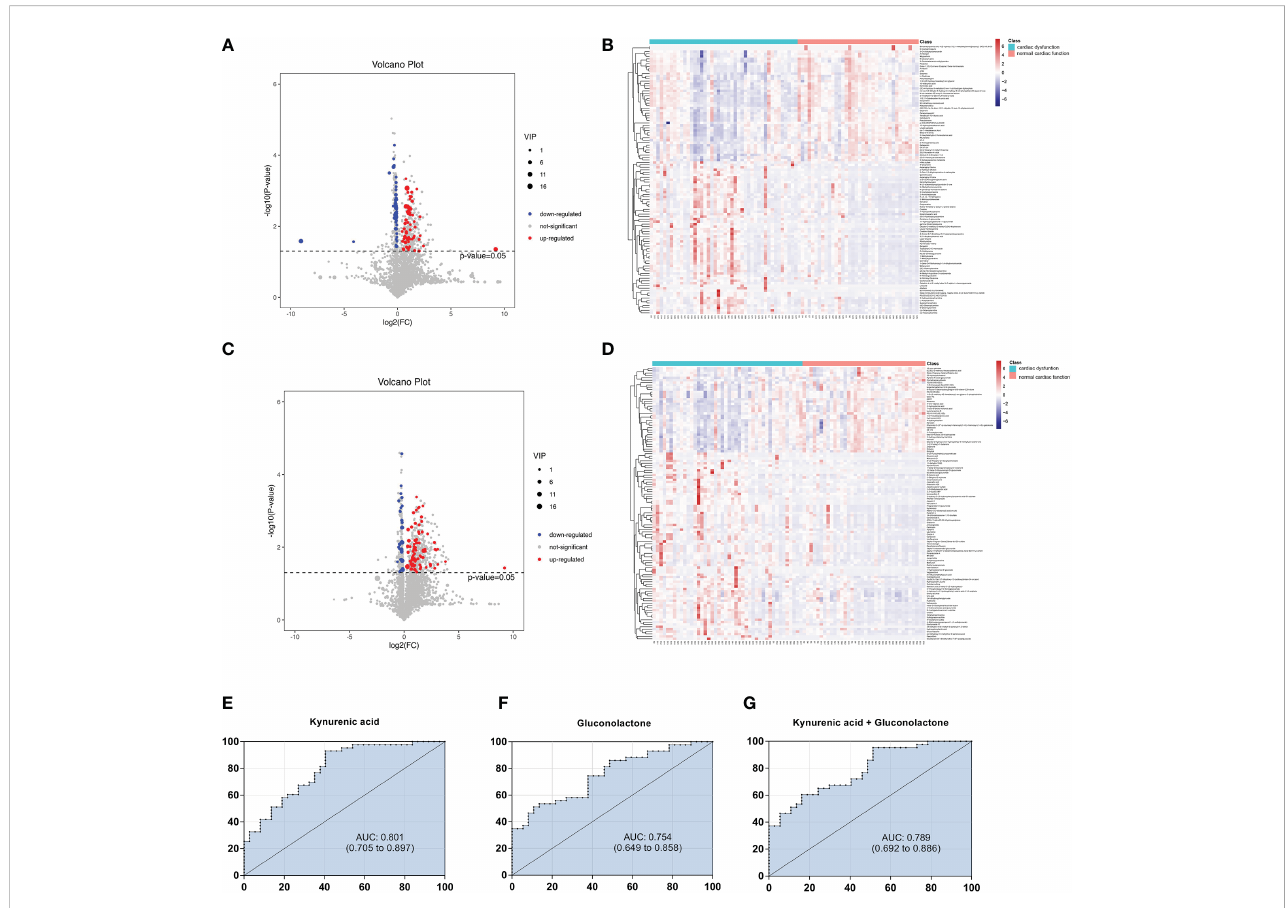
FIGURE 3 Volcano diagrams and heatmaps in total patients. (A) Volcano map in positive ionization mode. (B) Heatmap in positive ionization mode. (C) Volcano map in negative ionization mode. (D) Heatmap in negative ionization mode. In the volcano diagrams, the red dots represent up-regulated metabolites, and the gray dots represent no signi fi cant difference, and the blue dots represent down-regulated metabolites. (E – G) ROC curve analysis of the ability of differential metabolites to predict sepsis with cardiac